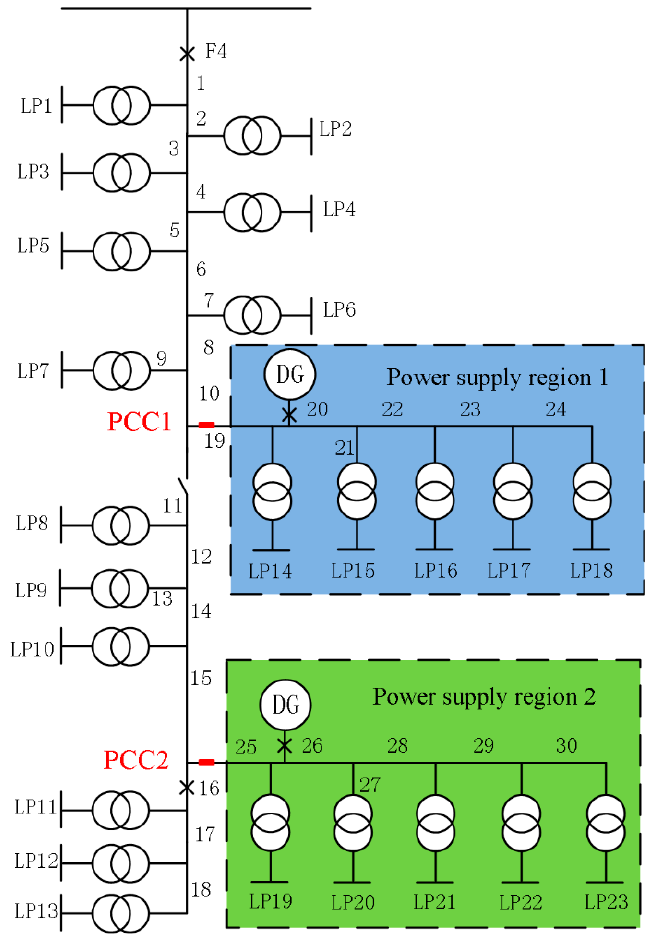
Figure 6. Bus6 F4 feeder system.